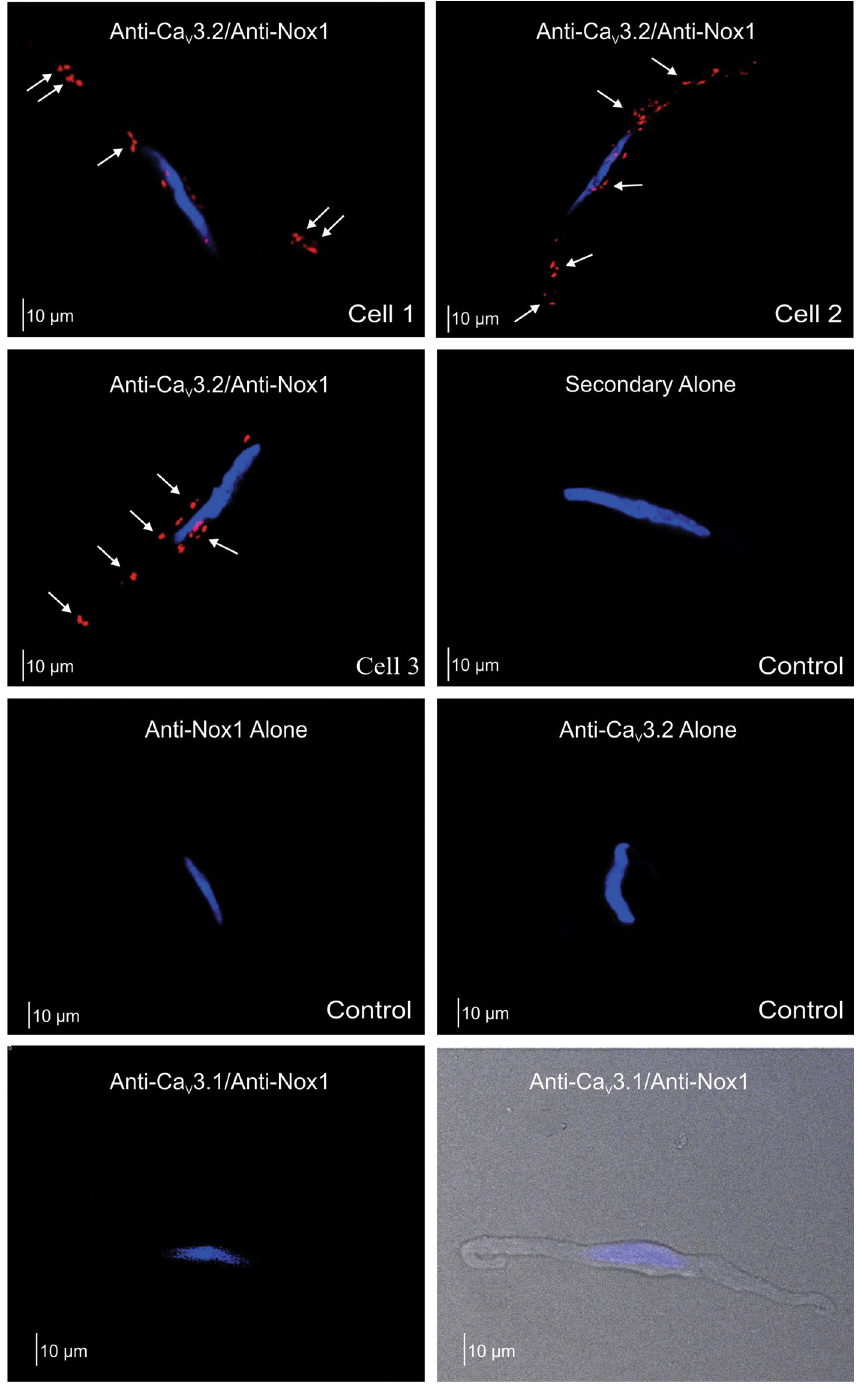
Figure 6. Proximity ligation assay of Ca V 3.2 and Nox1 in cerebral arterial smooth muscle cells. Representative images revealing the close proximity ( < 40 nM) of Ca V 3.2 with Nox1 as demonstrated by the presence of red fluorescent products; nuclei were labelled with DAPI (blue). A similar localization pattern between Nox1 and other vascular T-type channels (Ca V 3.1) could not be detected. Assay controls were performed with one or both primary antibodies removed. Each experiment was performed on cells for 4 different animals; photomicrographs are representative 10–20 smooth muscle cells per